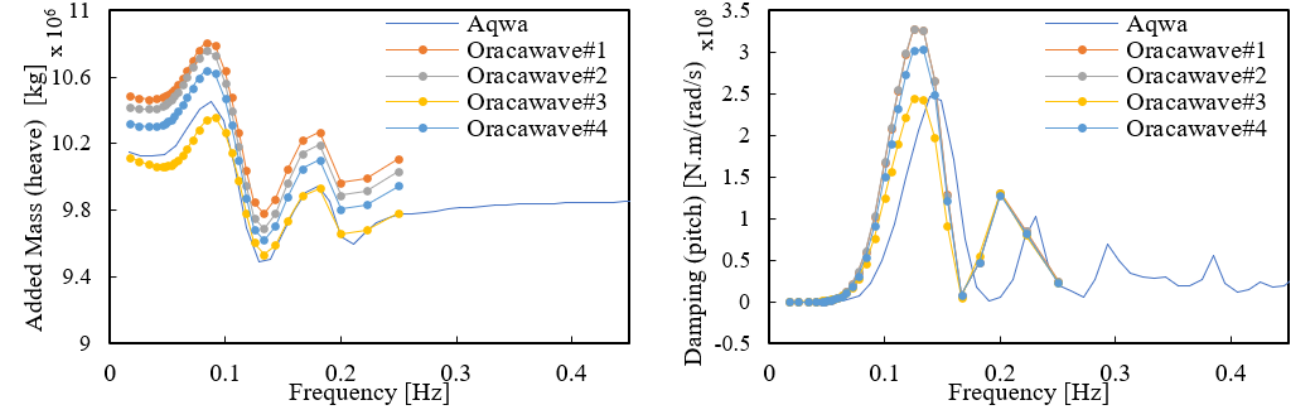
Figure 16. Five ‐ column platform hydrodynamic result (heave and pitch).